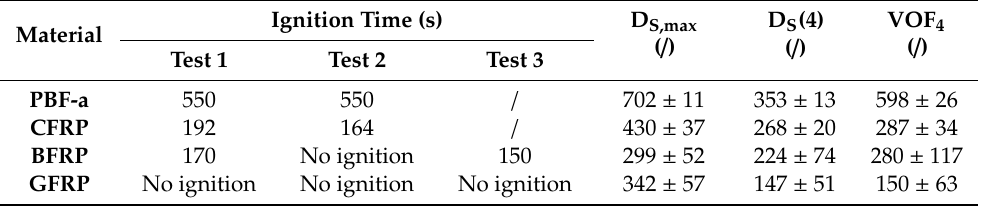
Table A7. Smoke chamber test results of neat PBF-a as well as carbon, glass and basalt fiber reinforced